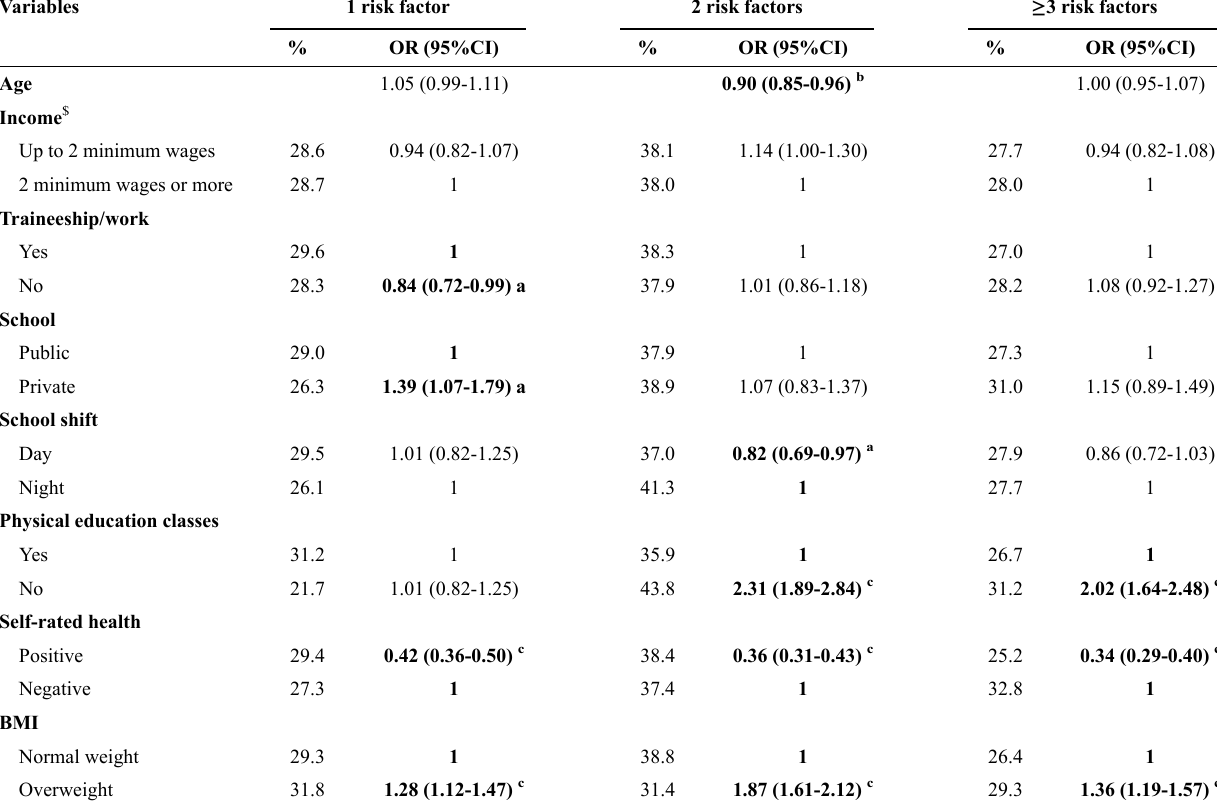
Table 4 - Multinomial analysis ₡ of modifiable risk factors for CVD and associated factors in girls. ACtVU Study. Uberaba, Brazil (2015). Variables 1 risk factor